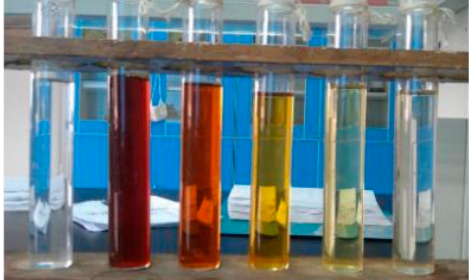
Figure 10. Effluent of catalytic-biological treatment portion (at 90th day). (Left to right: pure water/initial water/CBR-1/CBR-2/BAF-1/BAF-2).